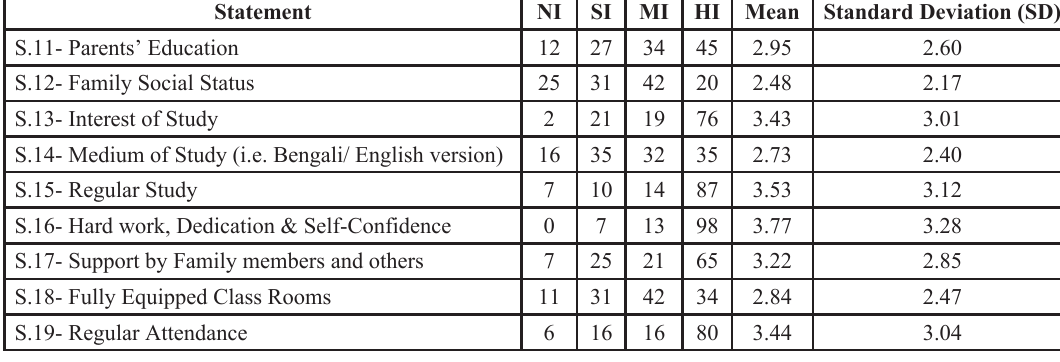
Table 1: Influential Statements and their Outcomes (S.11 to